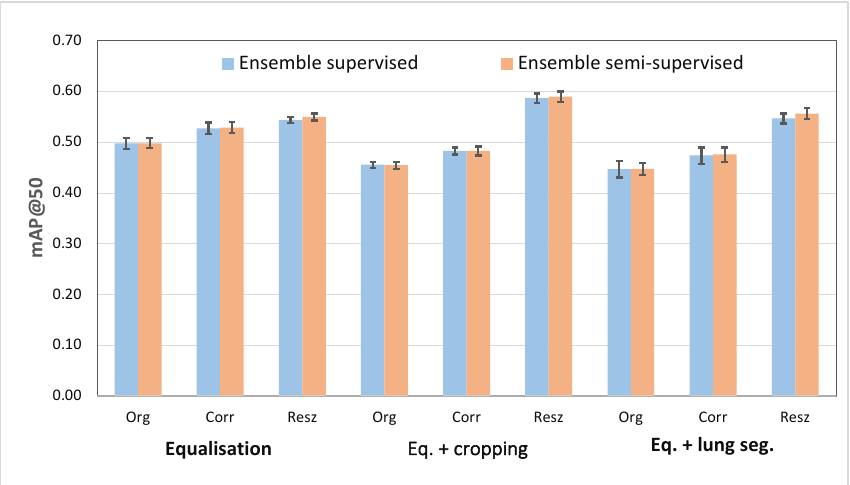
Figure 8. Best results for the ensembles with RetinaNet and Cascade